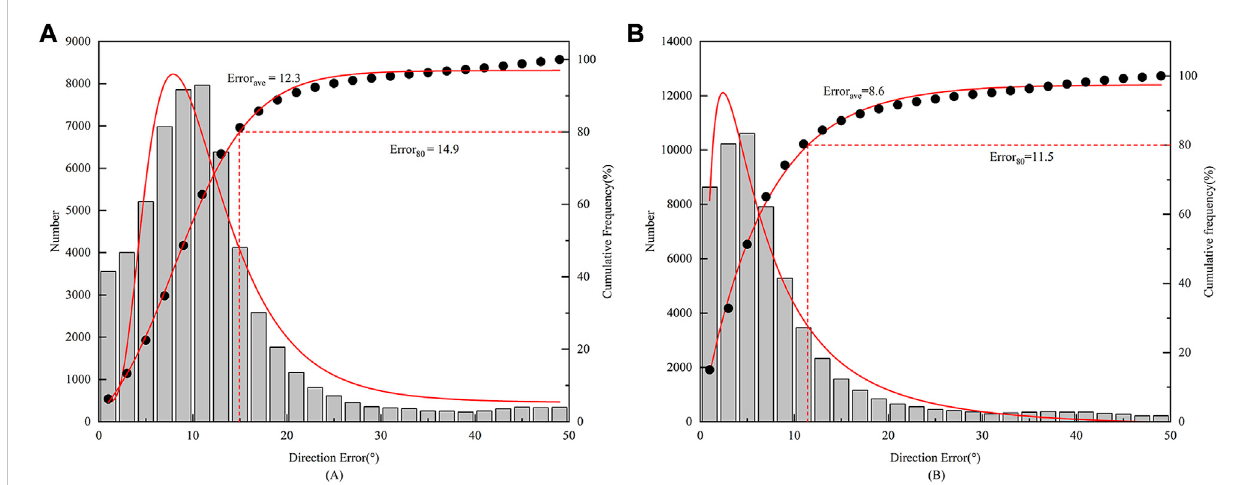
FIGURE 13 Comparedwiththemulti-stationresults,thedistributionofdirectionerrorofthesingle-site. (A) Notrevisedthesite-error; (B) Revisedthesite-error.